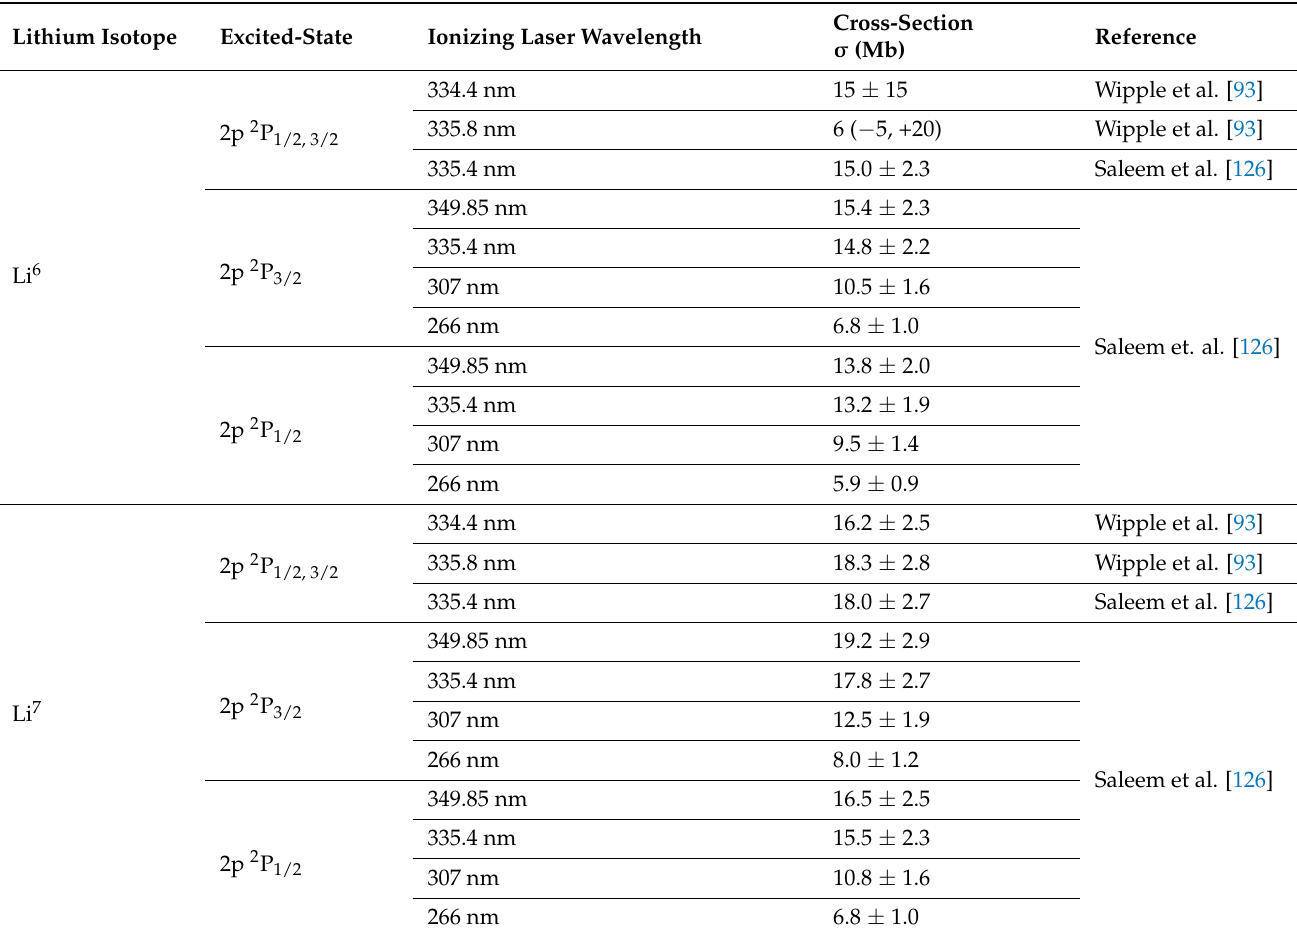
Table 2. Experimentally determined photoionization cross-sections from the 2p 2 P 1/2, 3/2 excited states of both isotopes of lithium at different ionizing laser